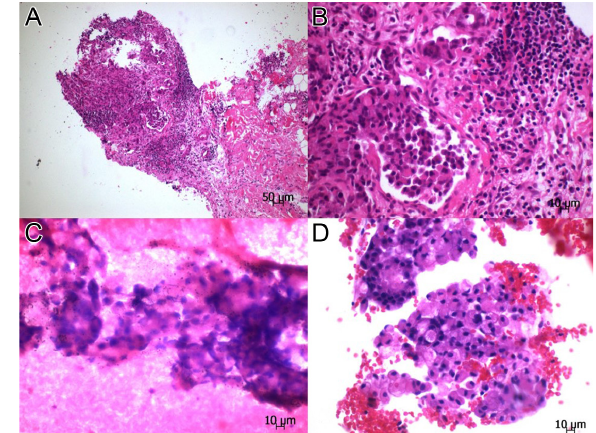
Figure 1. Adenocarcinoma formed by atypical cells infiltrating the lymph node in H&E sections of right axillary lymph node on tru-cut biopsy material (A,B). Adenocarcinoma in which signet ring cells and high columnar and cuboidal cells are formed by nuclear pseudostratification in EBUS material (H&E)